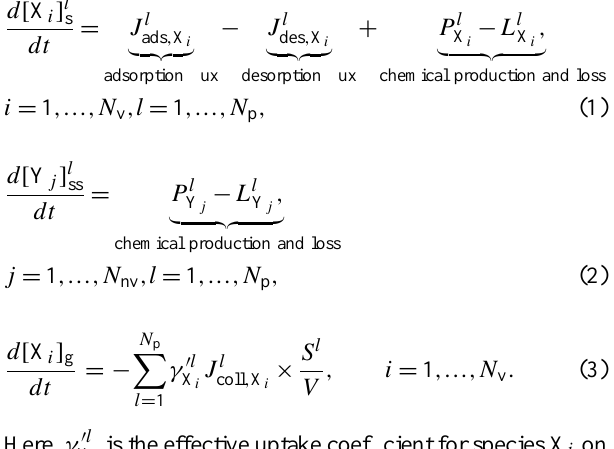
Heterogeneous reactions implemented in PartMC- MOSAIC with corresponding reaction rate coefficients and reaction